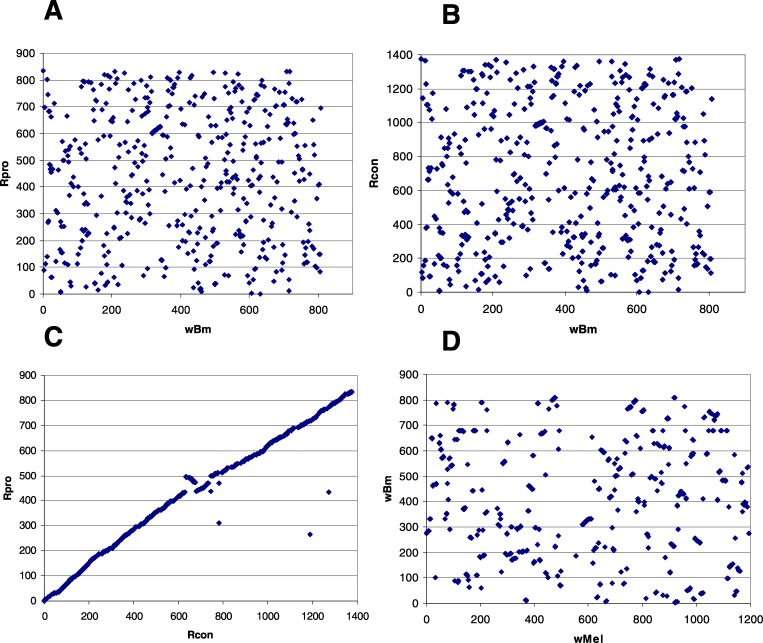
Absence of Gene Order Colinearity between wBm and Rickettsia and Disruption of Gene Colinearity between wBm and wMelEach dot represents a pair of probable orthologs defined as reciprocal BLAST best hits with E-value less than 0.001.(A) Genome dot-plot comparison of wBm (Wolbachia from B. malayi) and Rpro (R. prowazekii).
(B) Genome dot-plot comparison of wBm (Wolbachia from B. malayi) and Rcon (R. conorii).
(C) Genome dot-plot comparison of Rpro (R. prowazekii) and Rcon (R. conorii).
(D) Genome dot-plot comparison of wBm and wMel.